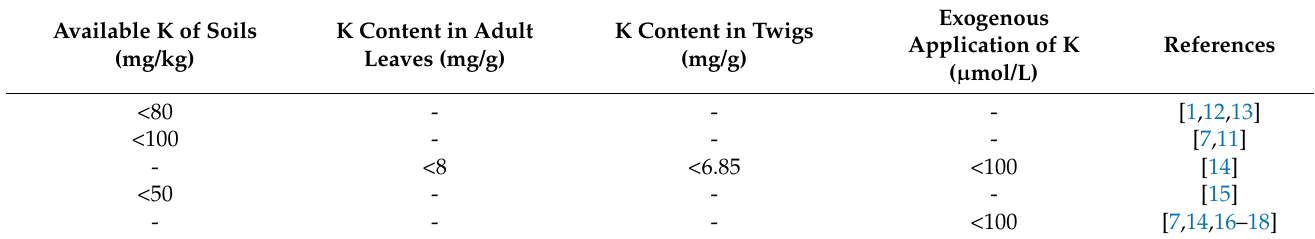
Table 2. The critical value of